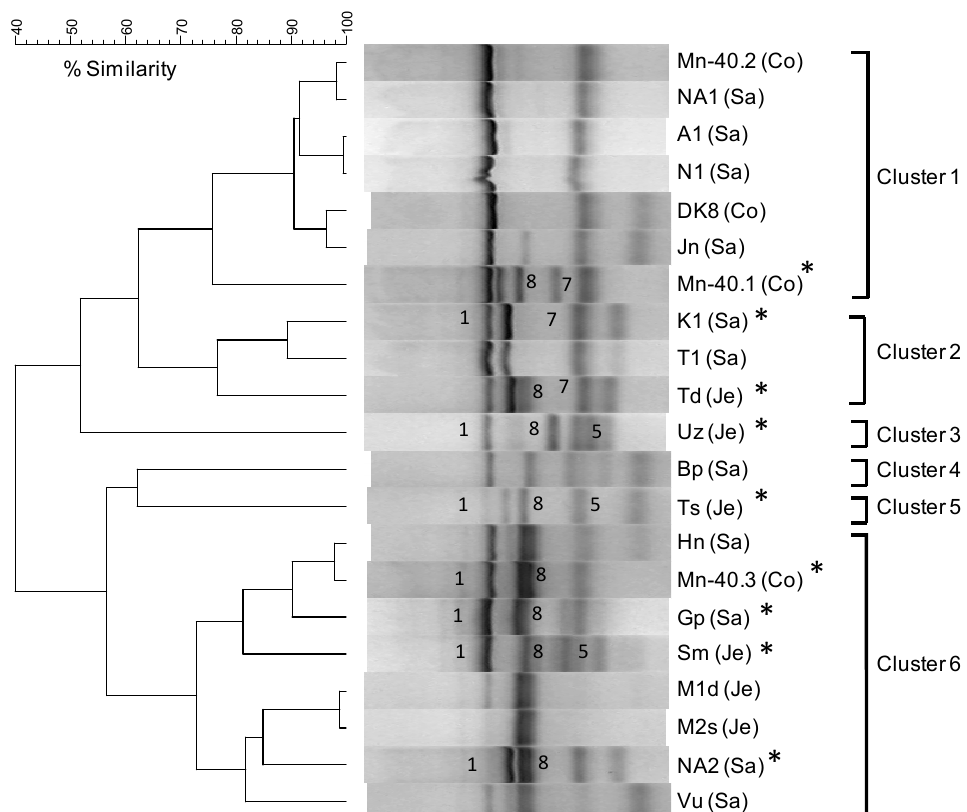
Figure 3. UPGMA cluster analysis of RFLP profiles of arsenite oxidase genes (aioA) in twenty-one CAO enrichments. Asterisks indicate enrichments that were selected for preparation of clone libraries; numbered band positions refer to the phylotype for which sequences were cloned. Enrichments were assigned to clusters on the basis of >65% similarity.